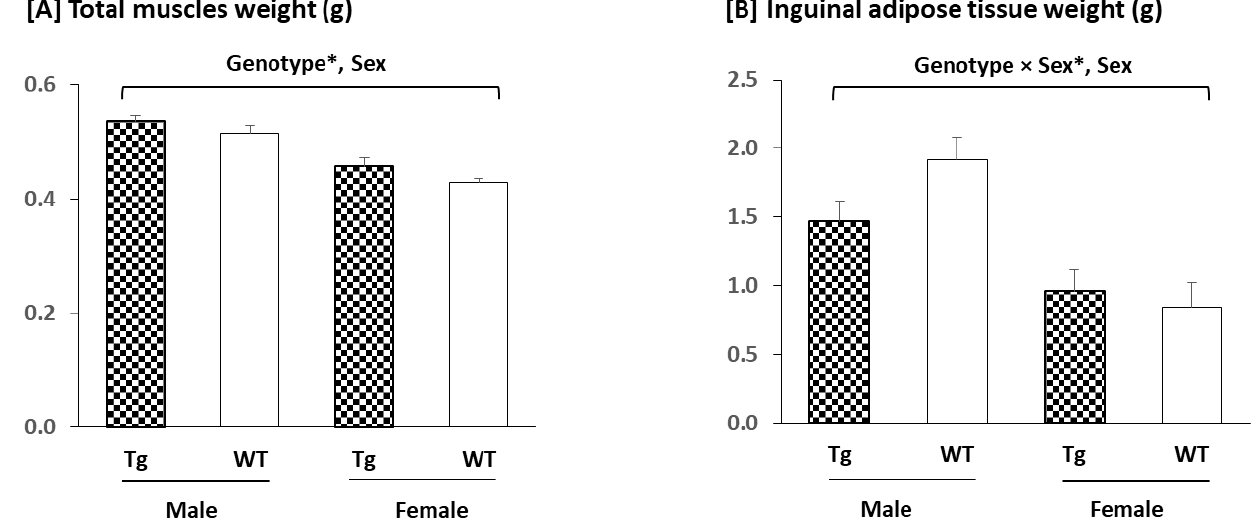
Figure 3. Total muscle and inguinal adipose tissue weights: ( A ) Sparc overexpression tended to increase the total skeletal muscles (gastrocnemius, soleus, tibialis anterior, and extensor digitorum longus) weight. Male mice had a heavier muscle weight than female mice. For the inguinal adipose tissue ( B ), the Sparc overexpression decreased its weight in male mice by 23%. Male mice had more inguinal adipose tissue than female mice. All data are mean ± SEM. The number of mice: 5 – 11 mice per experimental condition. *: Trend (0.05 ≤ p ≤ 0.1). Abbreviations: g, gram; Sparc , secreted protein acidic and rich in cysteine; Tg, transgenic ( Sparc overexpression); WT, wild-type.